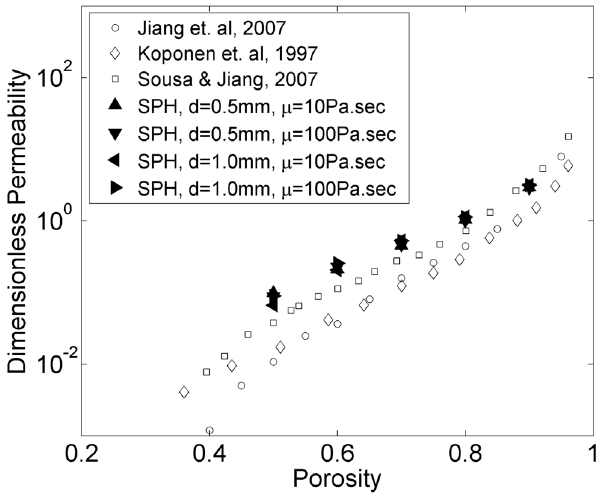
Figure 5. Dimensionless permeability vs. porosity.